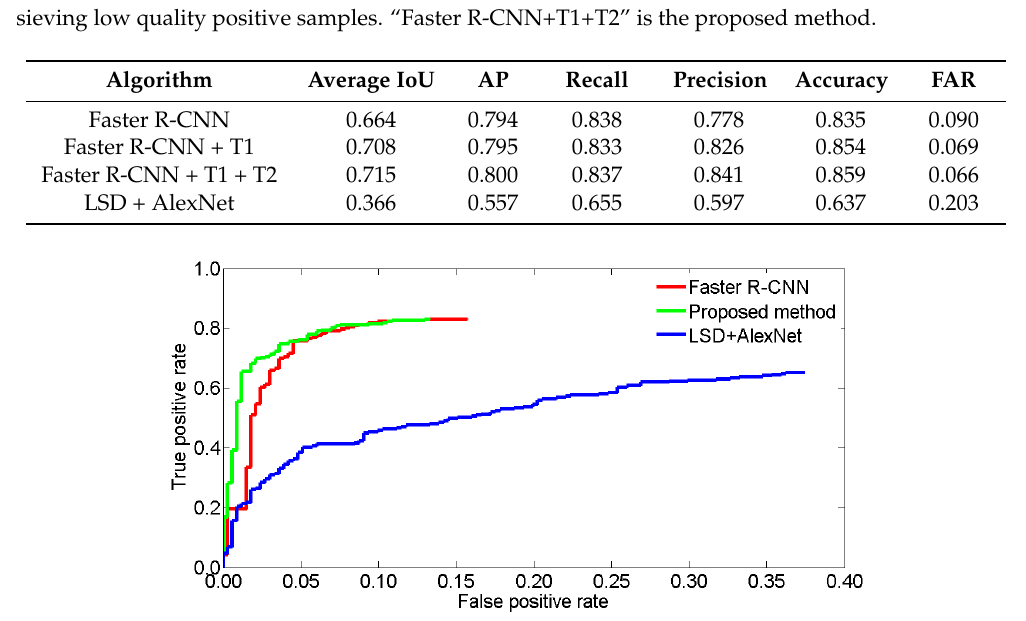
Figure 12. ROC graphs.